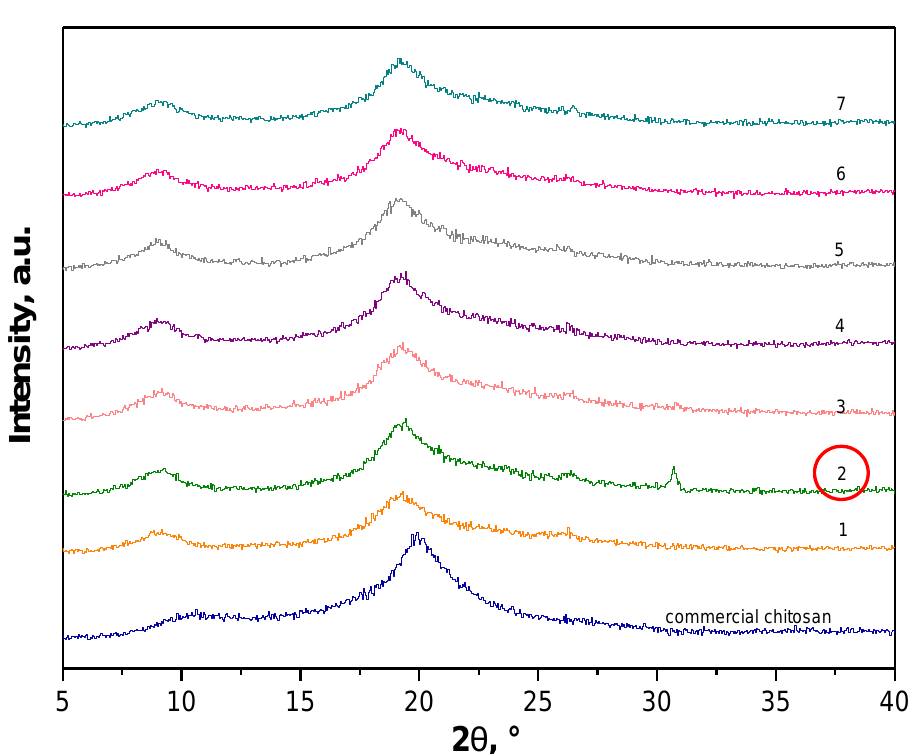
Figure 3. XRD analysis of obtained fractions compared to the diffraction pattern of commercial chitosan. Obtained diffraction patterns allowed to conclude enabled the statement that chemical structure of the fractions obtained by means of the above-mentioned parameters were very similar and relatively close to the XRD diffraction pattern of commercial chitosan. On all XRD diffractograms pattern peaks at approx. 2 θ = 9 ◦ and 2 θ = 19 ◦ were observed which correspond to the XRD pattern of standard chitin. Importantly, XRD peaks characteristic for chitosan are at approx. 2 θ = 10 ◦ and 2 θ = 20 ◦ (JCPDS # 039-1894) [28,29]. Additionally, a pattern peak at approx. 2 θ = 26 ◦ (very slight) and 2 θ = 31 ◦ was observed for sample 2. XRD peaks characteristic for chitin are also at approx. 2 θ = 23 ◦ and 2 θ = 26 ◦ [30] thus it was assumed that such peaks may also be assigned to these characteristics for chitin while their shift may be caused by the fact that the tested fraction apart from chitin consisted also of other components such as pigments or proteins which will be removed in the next steps of the performed chemical treatment. Therefore, due to the fact that the XRD pattern of sample 2 contained probably four pattern peaks characteristic for chitin and, notably, it was stated that at this step of the process the tested material should resemble chitin more than chitosan, sample 2—the sample obtained as a result of 4 extraction cycles and demineralization performed using 2 M HCl for 30 min—was selected for further process. XRD diffractogram of this sample and XRD diffractogram of commercial